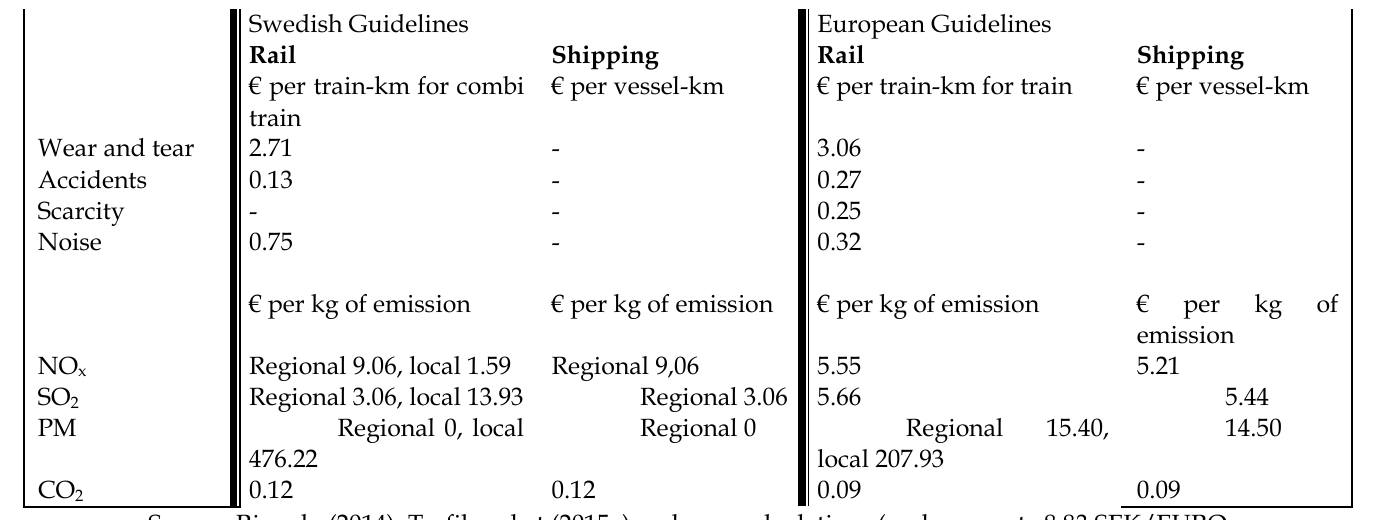
Table 3. Social costs of rail and shipping under Swedish and European guidelines Swedish Guidelines European